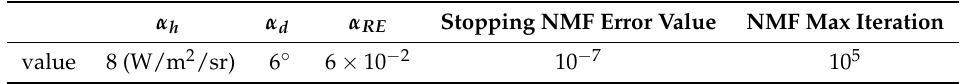
Table 8. HBEE-LCNMF parameter values for the Mauzac data set.